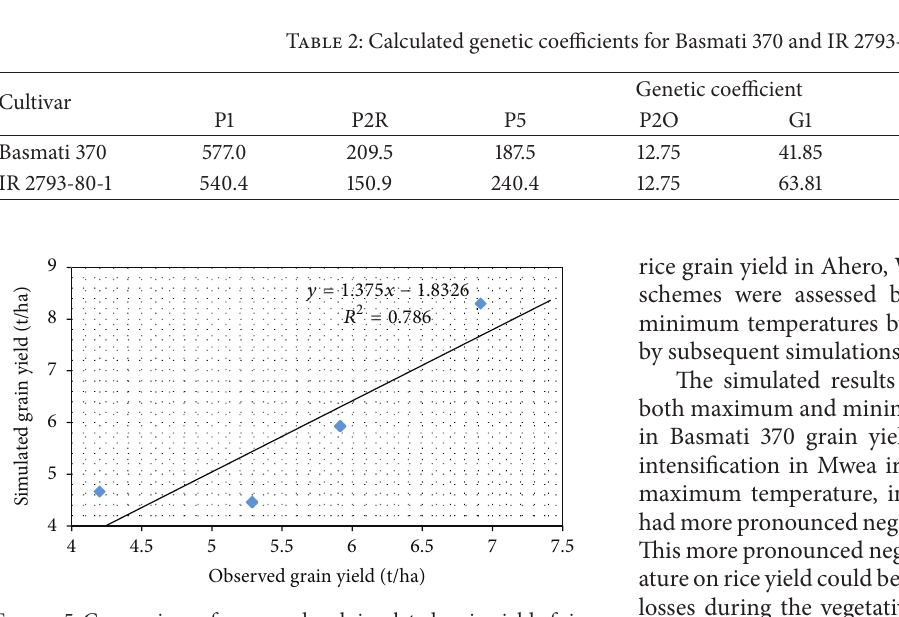
Figure 5: Comparison of measured and simulated grain yield of rice under SRI 2011.